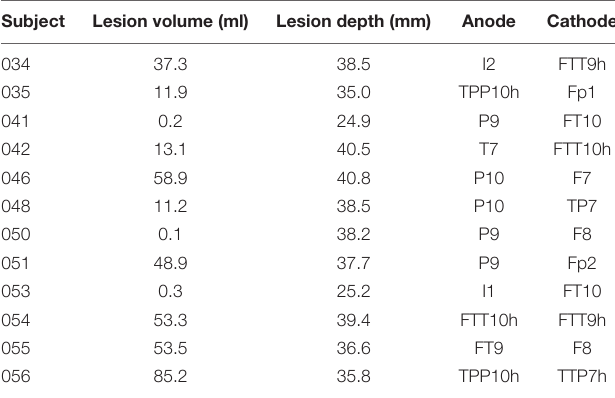
TABLE 1 | Stroke lesion volume and optimal stimulation pairs to estimate the lesion conductivity for each